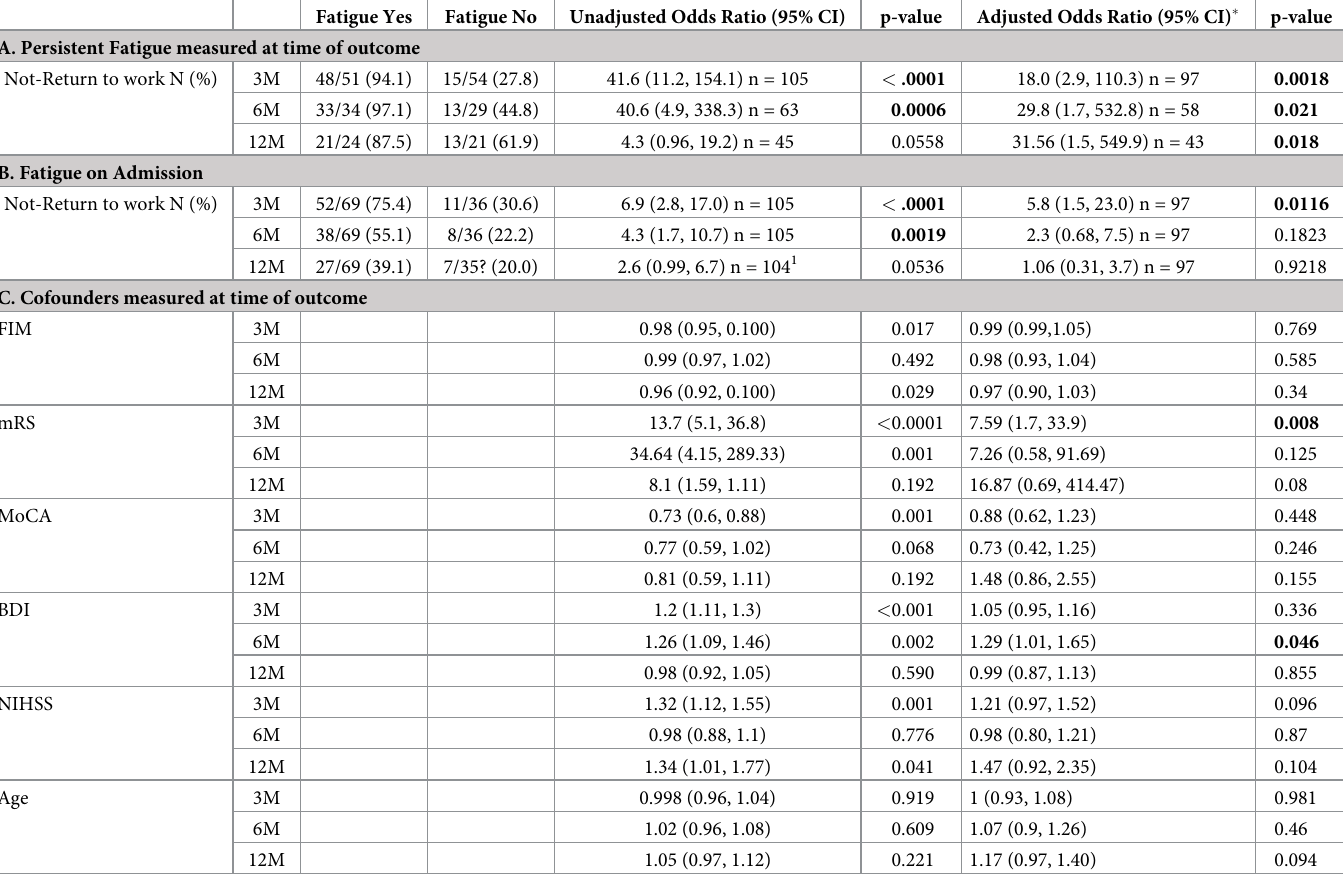
Table 2. Association between fatigue and cofounders and not returning to